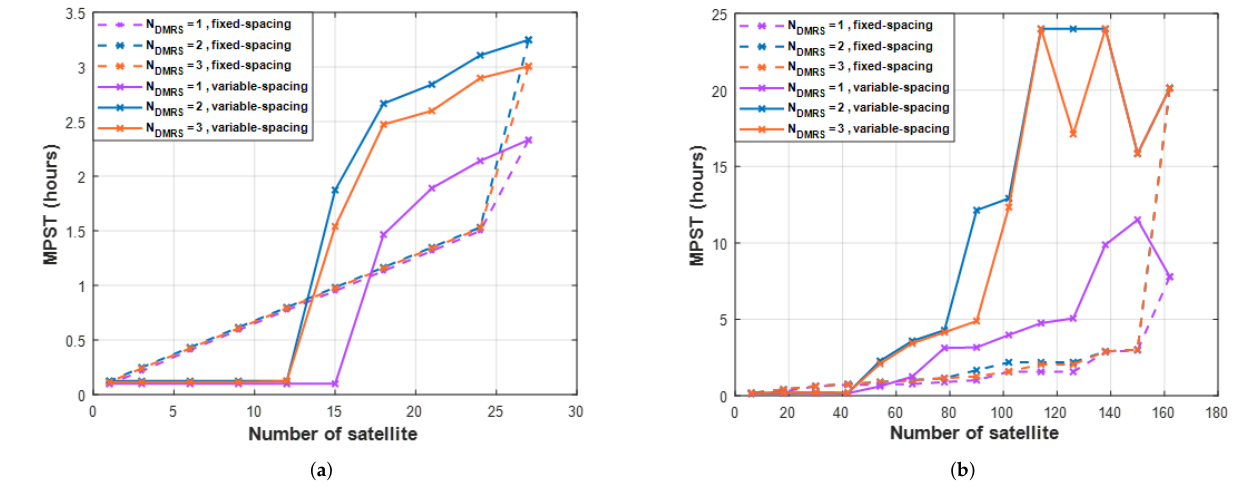
Figure 16. The maximum persistent service time ( MPST ) for different numbers of DMRS symbols per slot. ( a ) one orbit, ( b ) six